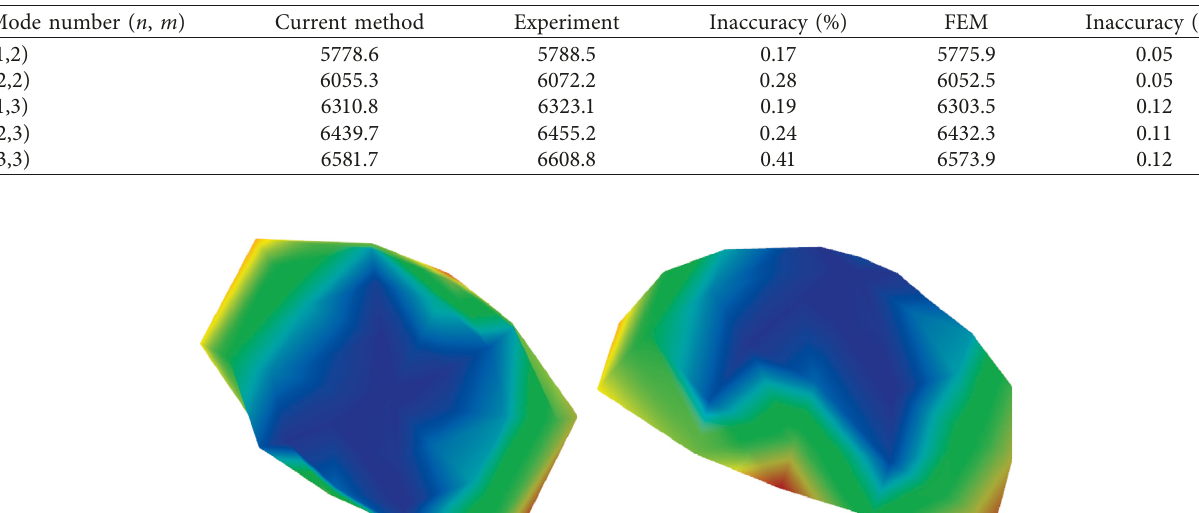
Table 5: Natural frequencies (Hz) of the tested spherical cap using different methods.